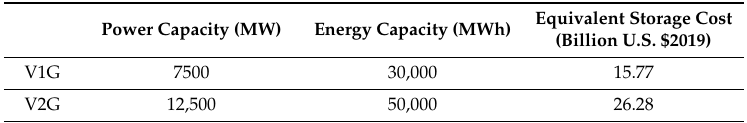
Table 18. Stationary Storage Equivalents and Relative Investment Costs to Managed Charging Scenarios in California—Mid Demand 2030